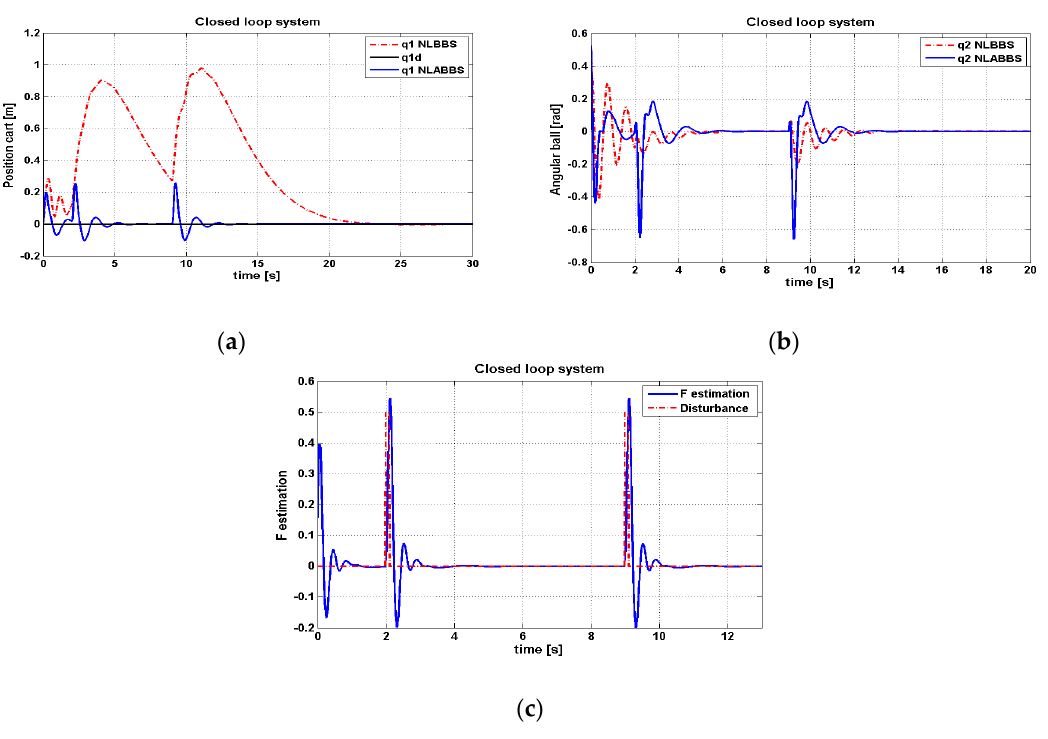
Table 6. Dynamic performance of the ball–arc system based on the controllers with disturbance.